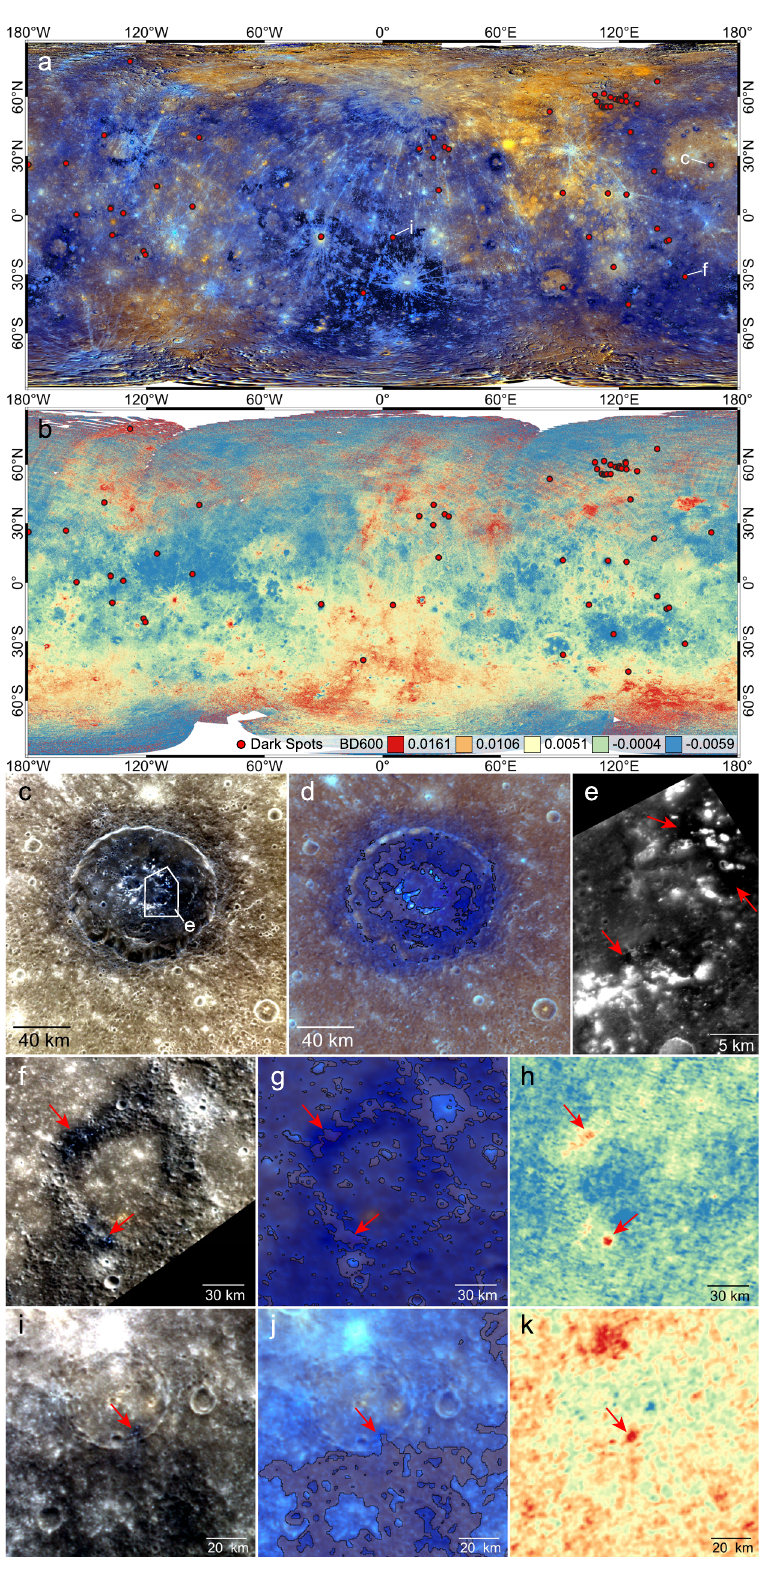
Fig. 1 Occurrence of dark spots on Mercury and their relationship with LRM. a The global distribution of dark spots (red dots) and LRM 29 (black shades) on Mercury. b Most dark spots occur in areas with positive BD600 values that is correlated with graphite contents (see Methods). c Dark spots in the Atget crater (166.38 °E, 25.57 °N) that were not con fi rmed previously 24 . d LRM (translucent brown shades) is widespread in the peak ring of Atget crater. e A detailed view of dark spots in the peak ring (red arrows) with the lowest re fl ectance. Dark spots occur in regions that have higher positive BD600 values than the surrounding LRM (translucent brown shades) and other background units. f – h Two dark spots (red arrows) on the rim of an unnamed crater (154 °E, 30 °S). i – k Dark spot (red arrow) located at 5.24 °E, 11.42 °S. Panels h and k are in the same stretch with b . Base images used in all the panels are listed in the Supplementary Table 2 and provided by National Aeronautics and Space Administration